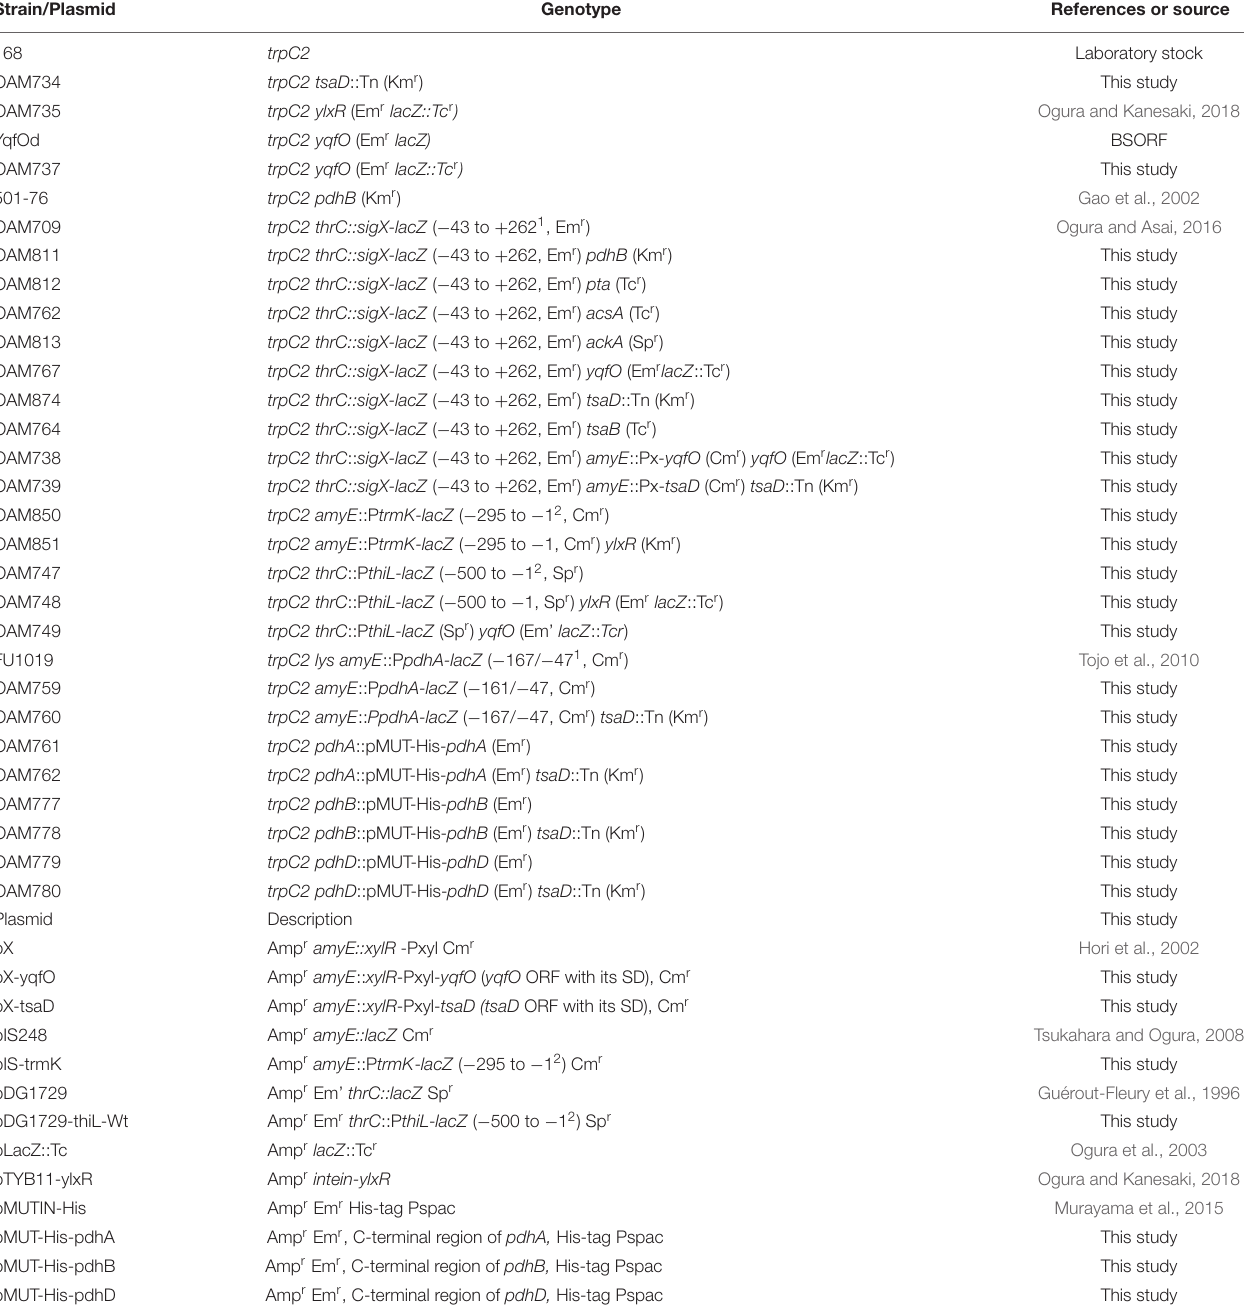
1 Numbers indicate the nucleotide positions ralative to the transcription start point for sigX-lacZ and PpdhA-lacZ. 2 Numbers indicate the nucleotide positions ralative to the translation start point for PtrmK-lacZ and PthiL-lacZ. The rests of the strains and plasmids for deleted and mutated PtrmK-lacZ and PthiL-lacZ fusions are listed in Supplementary Table S1 .